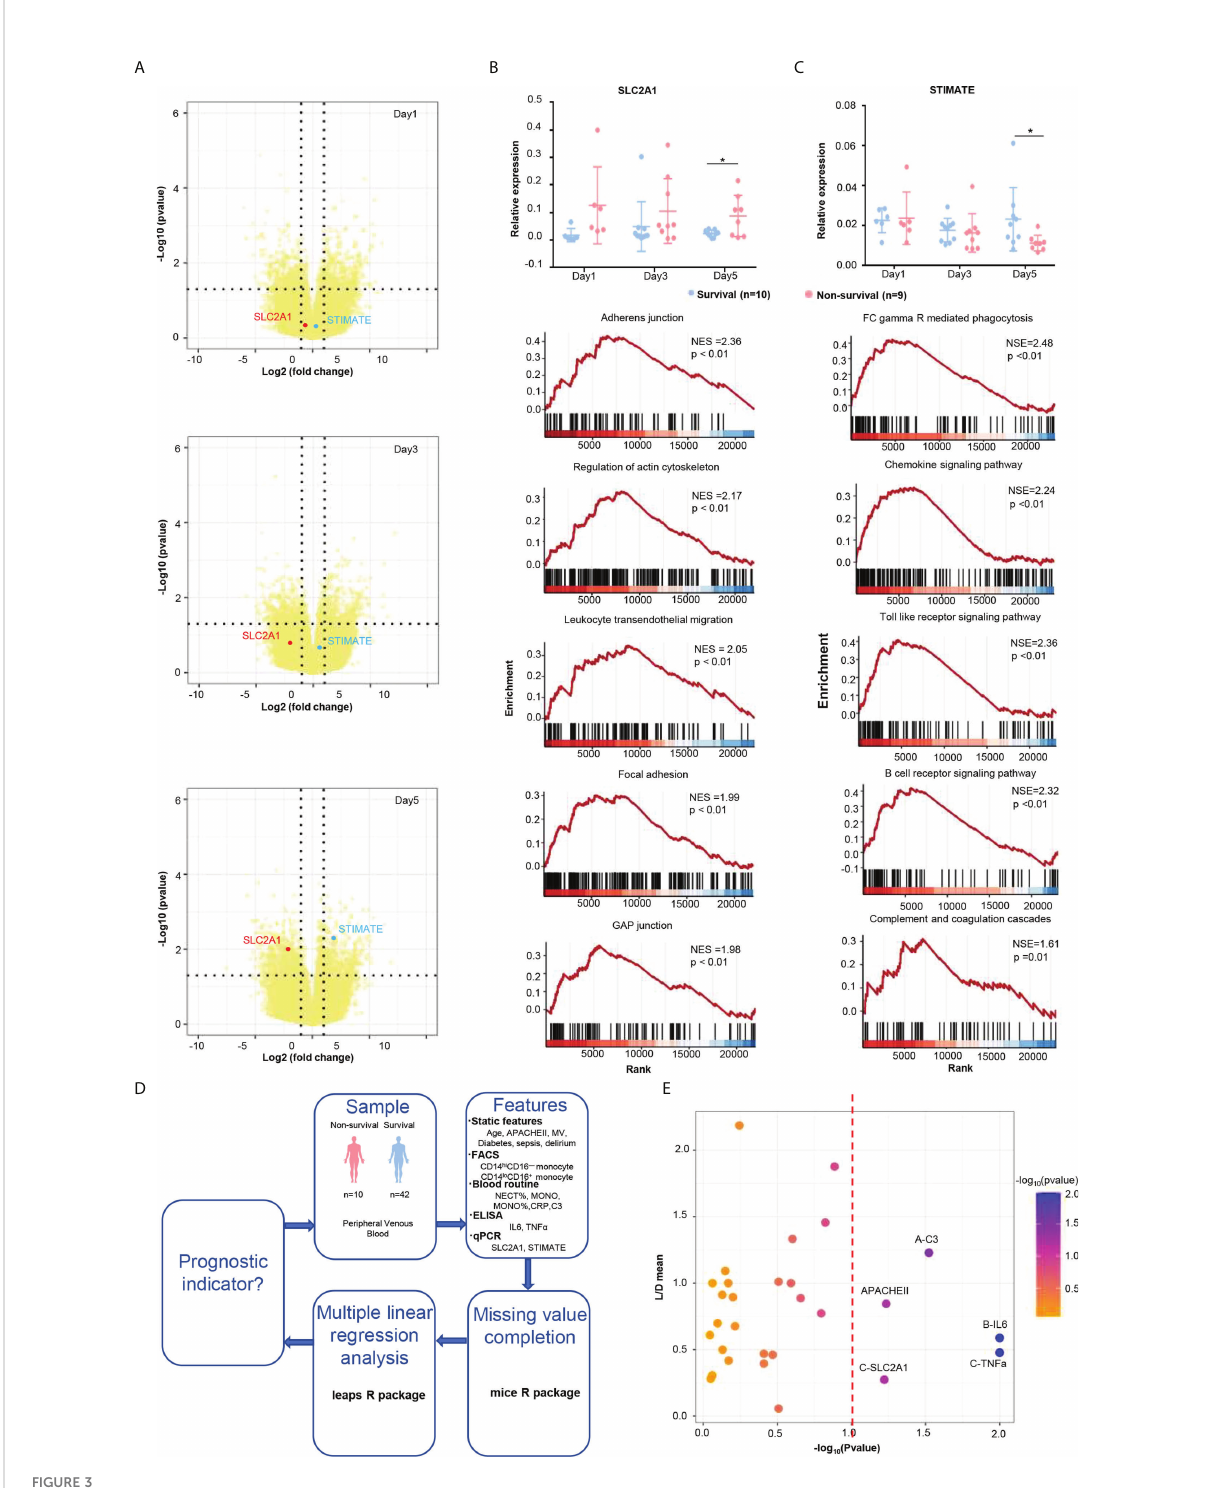
FIGURE 3 Poor prognostic indicators of ICU patients. (A) Volcano plot of the DE genes at days 1, 3, and 5. SLC2A1 is labeled as the red plot, and TIMATE is labeled as the blue plot. (B) qPCR validation and GSEA enrichment plots of SLC2A1. The 28-day survivors (blue dots) and nonsurvivors (red dots) were compared by t -test. Plots show mean and SD. (C) qPCR validation and GSEA enrichment plots of STIMATE. (D) Flowchart of prognostic feature analysis. The 28-day survivors (blue dots) and nonsurvivors (red dots) were compared by t -test. Plots show mean and SD. (E) Linear regression analysis of features that were potentially associated with poor prognosis. * refers to